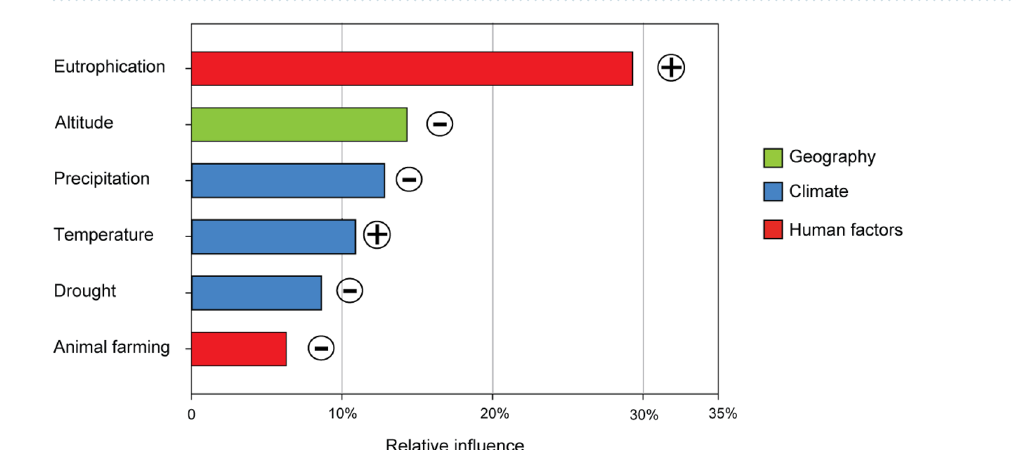
Figure 3. Relative influence of drivers affecting invasion degree, according to the outputs of BRT analysis. Pluses ( ⊕ ) and minuses ( ⊖ ) on the right of each bar represent the direction of the influence (positive and negative, respectively). Spatial autocorrelation explained 17.7% of the variation. See Supplementary Fig. 2 for additional details on the response variation through the gradient of each